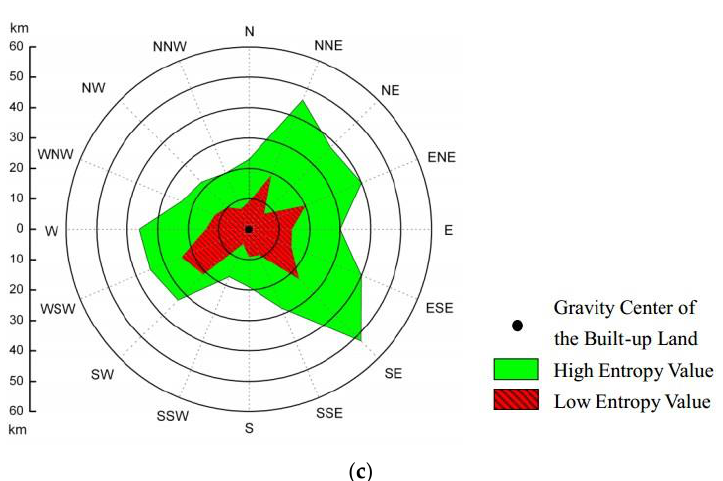
Figure 5. Latitude direction ( a ); longitude direction ( b ) and radius direction ( c ) recognition result.